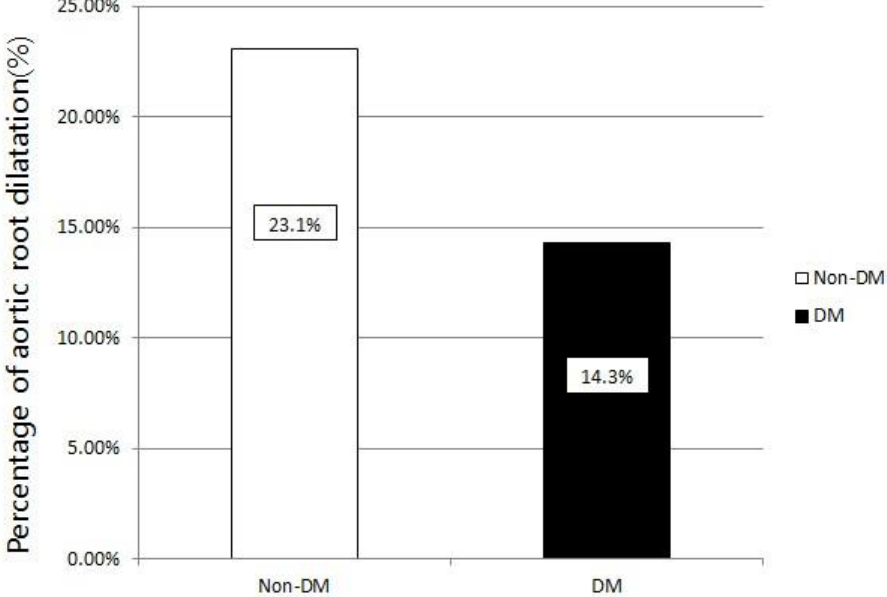
Figure 1. Percentage of aortic root dilatation in patients with or without diabetes. Aortic root dilatation was defined as aortic root diameter (ARD)/body surface area (BSA) ≥ 2.1 cm/m 2 in women or 2.2 cm/m 2 in men. In patients with diabetes, the percentage of aortic root diameter dilatation was significantly lower, when compared with those without diabetes (14.3% vs. 23.1%, p = 0.022). DM, diabetes